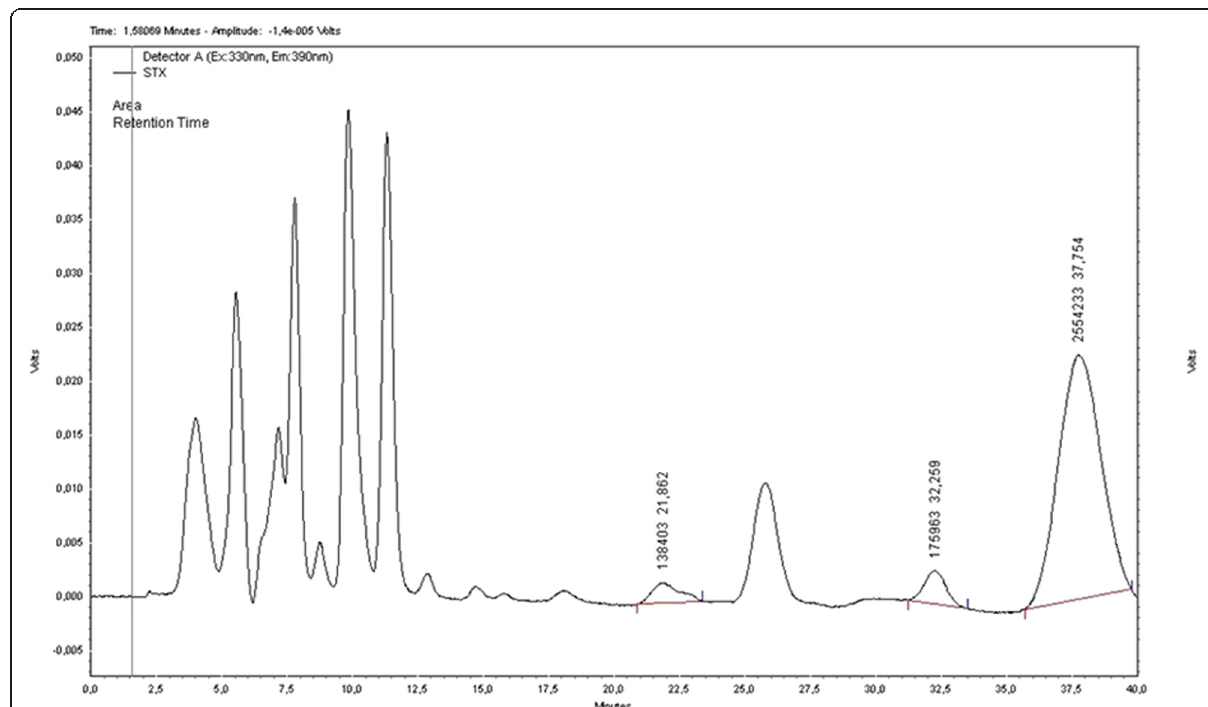
Fig. 1 Chromatogram showing PST from C. raciborskii used in the experiments. The toxin peak levels separated at 21.8, 32.2 and 37.7 min correspond to neosaxitoxin, dc-saxitoxin, and saxitoxin,